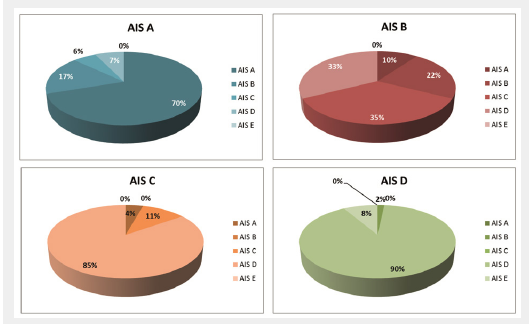
Conversion in neurological status after SCI. The percentage of patients that convert to another neurological category according to the International Standards for Neurological Classification of Spinal Cord Injury differs widely between the categories AIS A (sensory- motor complete), AIS B (motor complete, but sensory incomplete), AIS C and D, both sensory-motor incomplete, but AIS D patients have more than half of the muscles underneath the lesion graded as 3 or above. Conversion is largest in AIS B and C patients and smallest in AIS D patients. (Numbers are based on [12].)